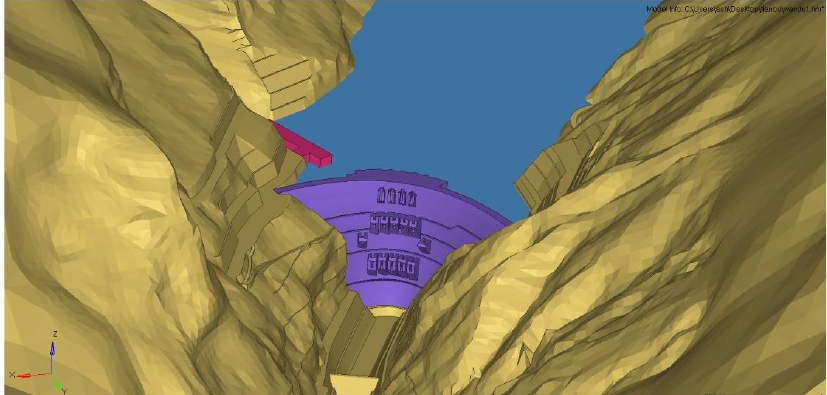
Figure 8. Finite element model for calculating the effect of solar radiation on reservoir water.